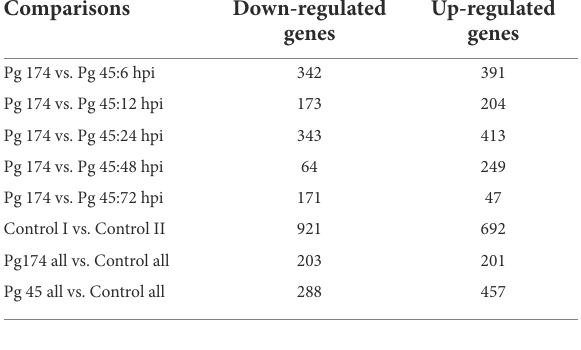
TABLE 3 Number of differentially expressed genes in M. grisea infected ICMB 93333 over different time-points. Comparisons